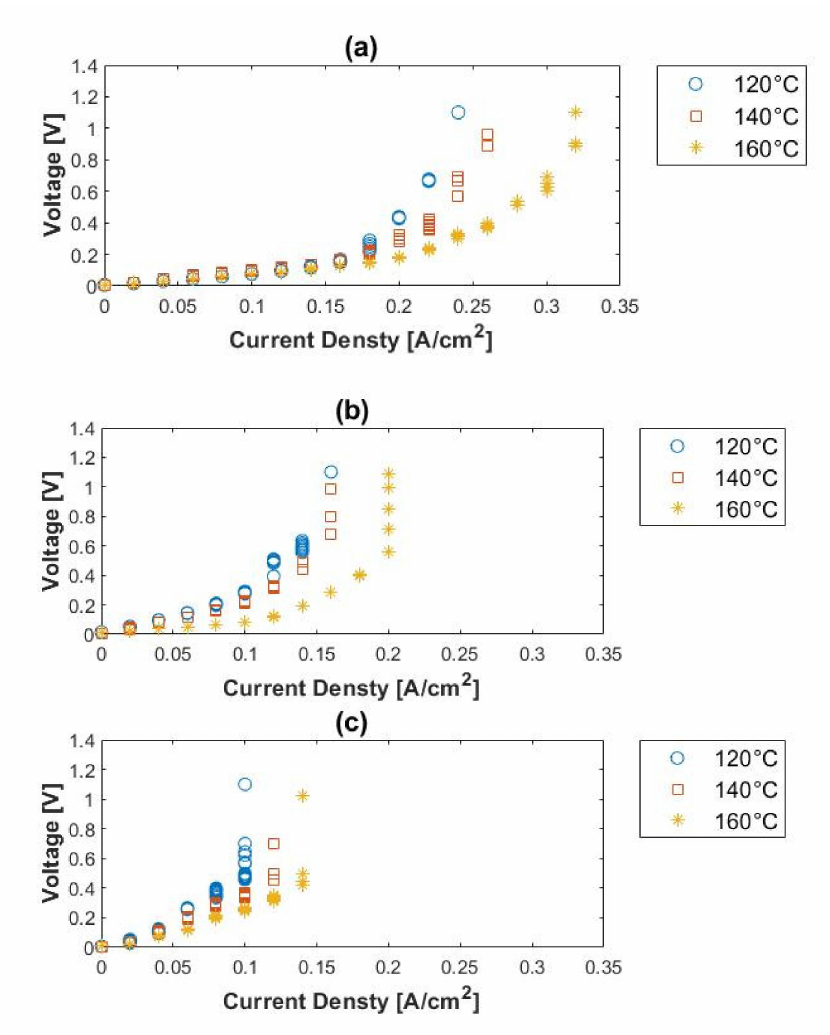
Figure 8. Polarization curves for ( a ) 10%, ( b ) 50%, and ( c ) 80% methane, balance hydrogen (hydrogen flow rate = 100 mL n /min, 1